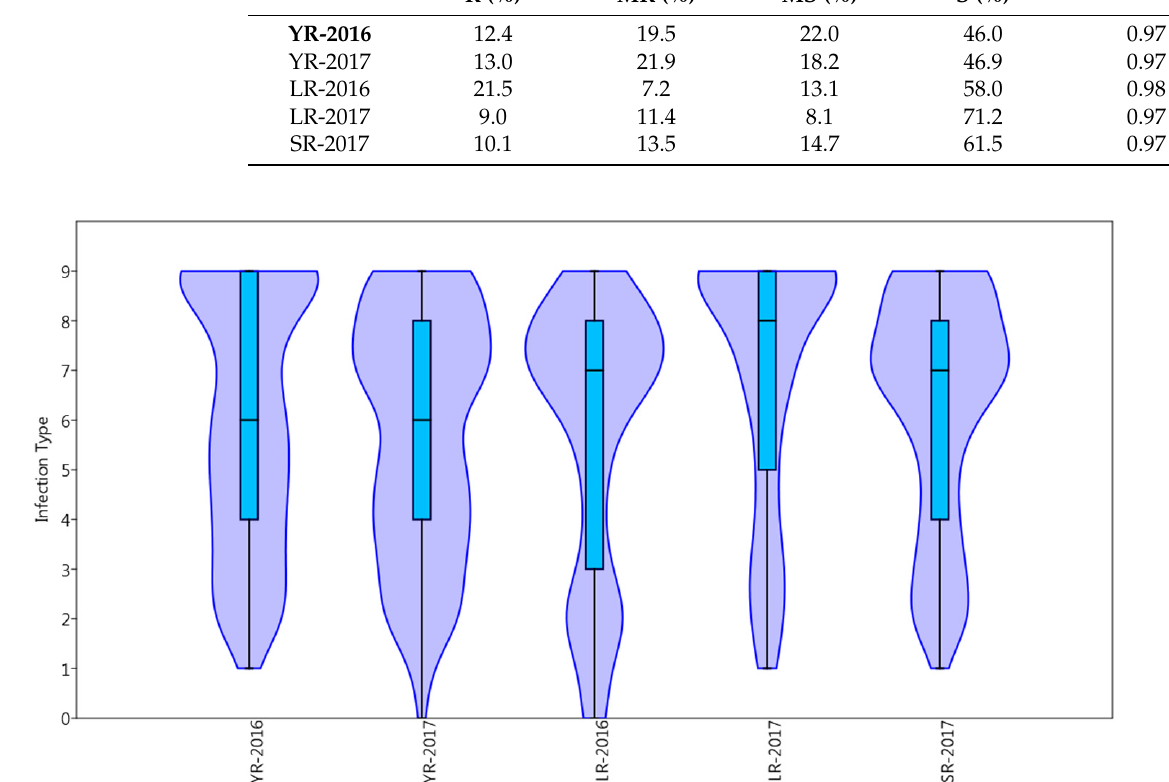
Figure 1. Violin and box plots of phenotypic distribution for yellow (YR), leaf (LR) and stem (SR) rusts, in 2016 and 2017, under field conditions. Table 1. Phenotypic percentage distribution for yellow (YR), leaf (LR), and stem (SR) rust, in 2016 and 2017, under field conditions.